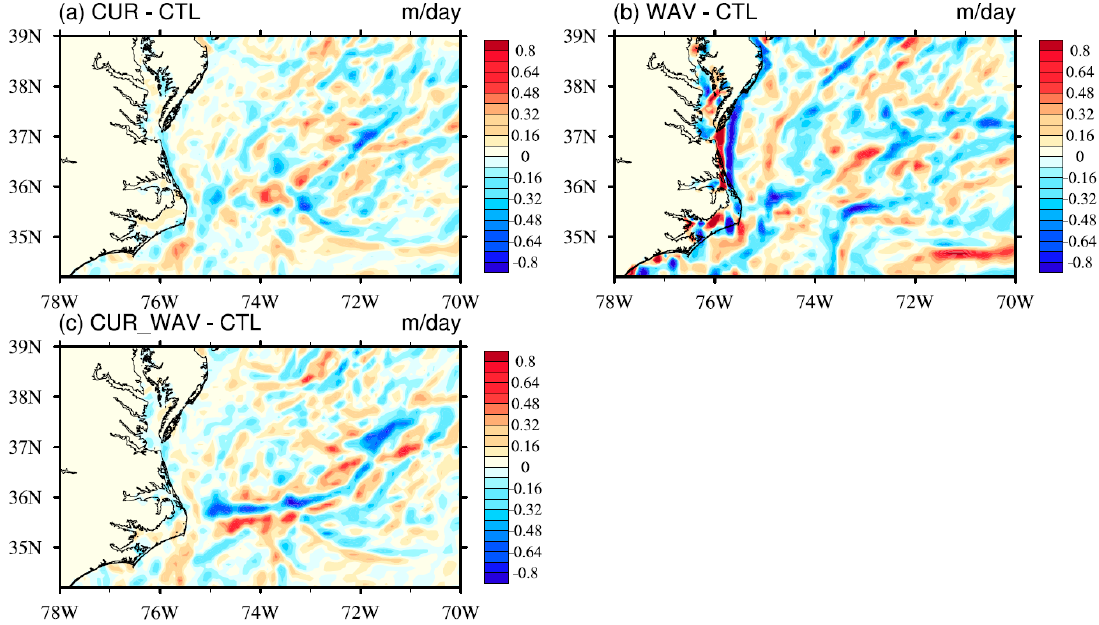
Figure 4. Ekman pumping (color shaded, m / day) response to ( a ) surface currents and wind stress coupling (CUR-CTL), ( b ) waves and wind stress coupling (WAV-CTL), and ( c ) three-way coupling of surface current, waves, and wind stress (CUR_WAV-CTL) averaged over a 30 day period.